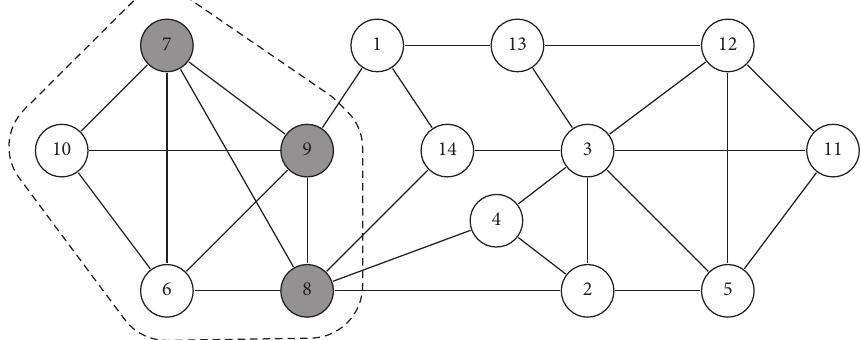
Figure 1: Running example (the number in each vertex denotes its vertex id and weight). Table 1: Summary of